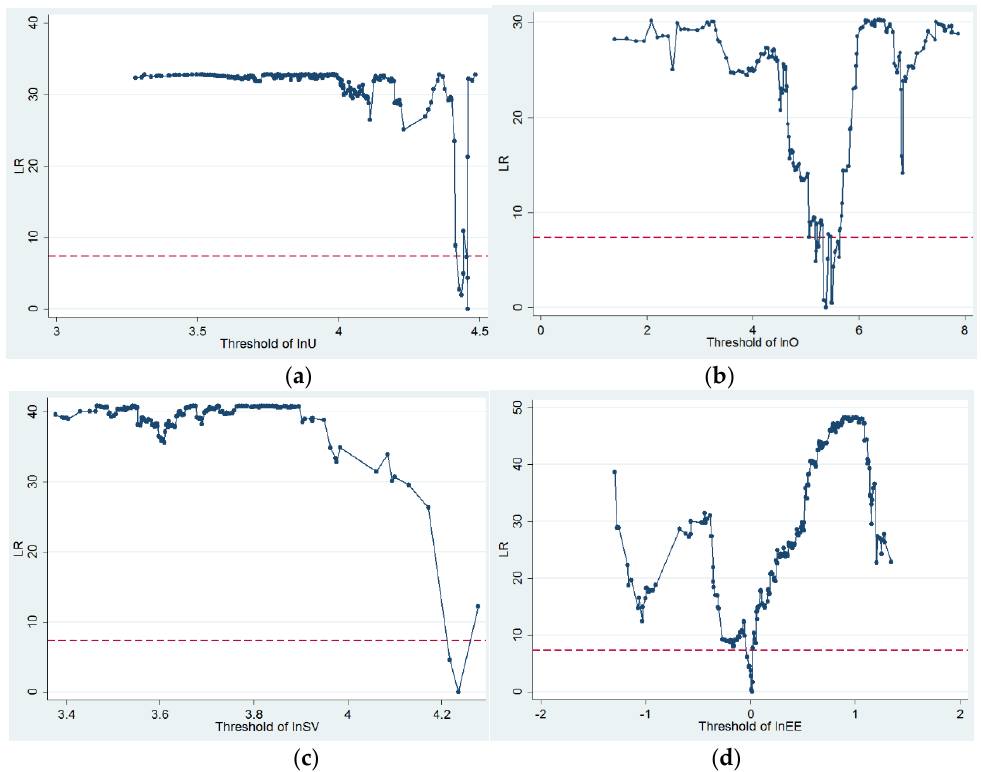
Figure 3. Likelihood ratio of each single threshold for each model: ( a ) model 5, ( b ) model 6, ( c ) model 7 and ( d ) model 8. and ( d ) model